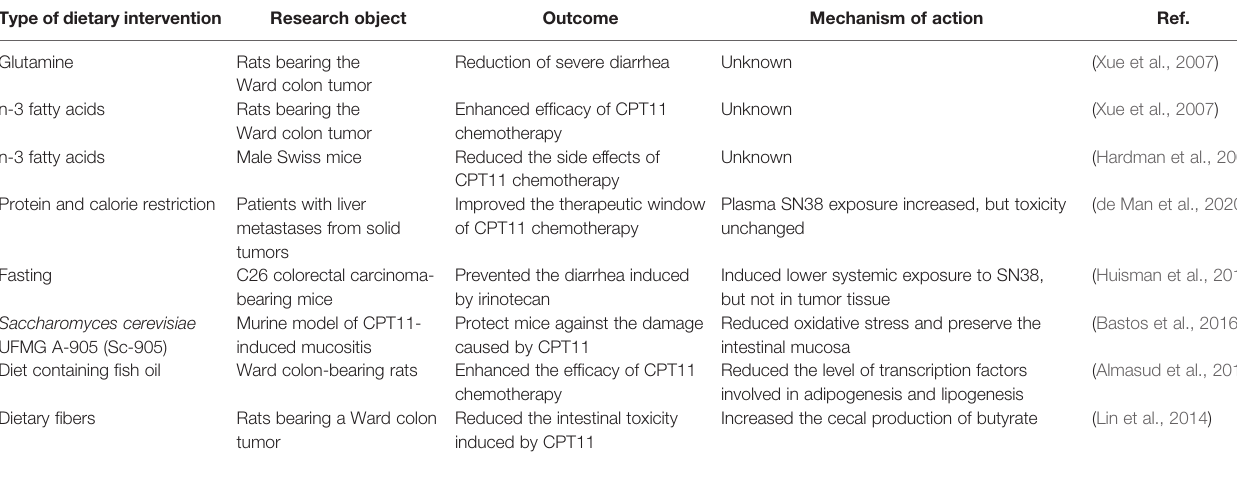
TABLE 1 | Outcomes of different dietary interventions upon CPT11 chemotherapy. Type of dietary